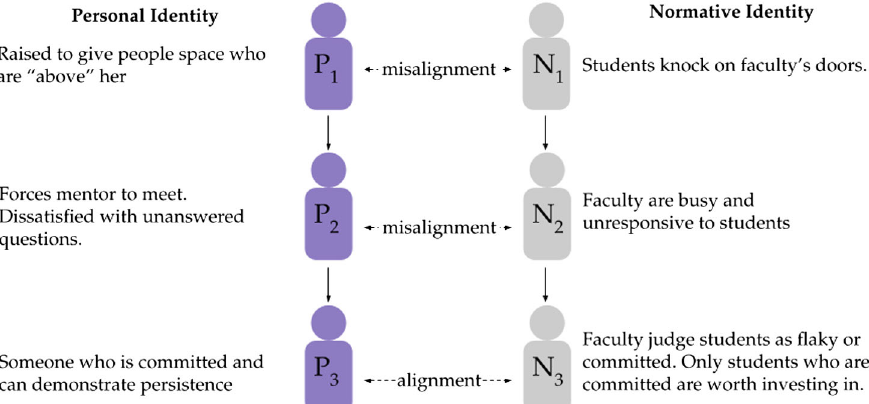
FIG. 4. Summary of Cassidy ’ s personal identity and perceived normative identity with respect to relationships between faculty and students in